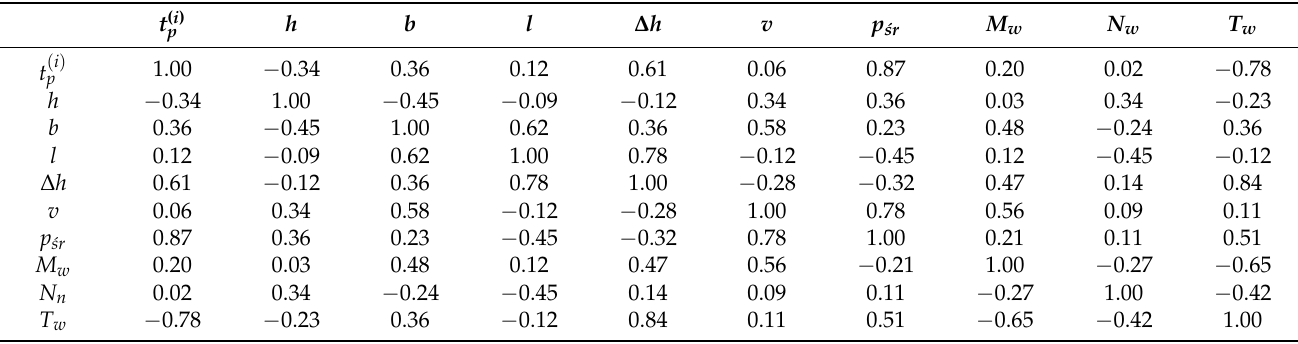
Table 1. Correlation matrix for the analyzed variables.